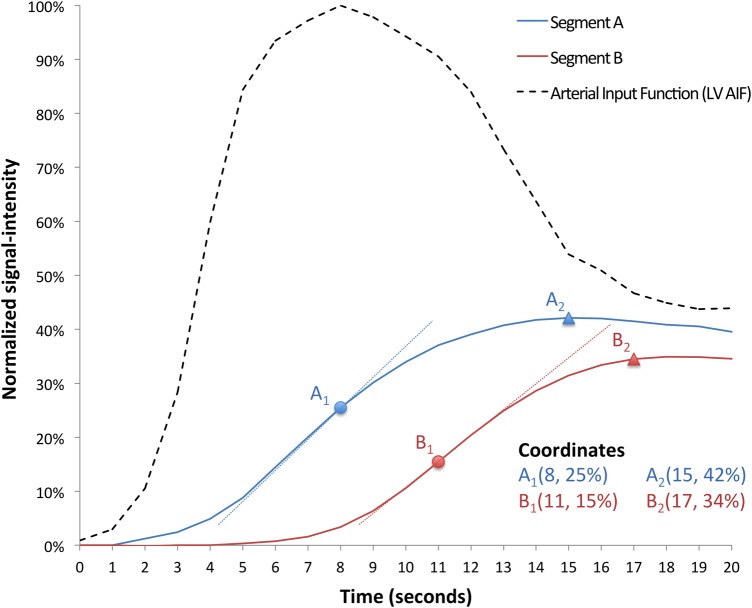
Schematic representation of perfusion dyssynchrony analysis. First-pass myocardial signal intensity curves are shown for two myocardial segments (Segment A and Segment B) and for the AIF measured from the LV cavity. A1 and B1 indicate the point of maximum signal intensity upslope in each segment. A2 and B2 indicate the peak of signal intensity in each segment. In this schematic example, the calculated perfusion dyssynchrony indices are coefficient of variation of time to maximum upslope (C-TTMU) 22%; variance of time to maximum upslope (V-TTMU) 2.3 s2; coefficient of variation of time to peak signal (C-TTP) 8.8%; variance of time to peak signal (V-TTP) 1 s2.